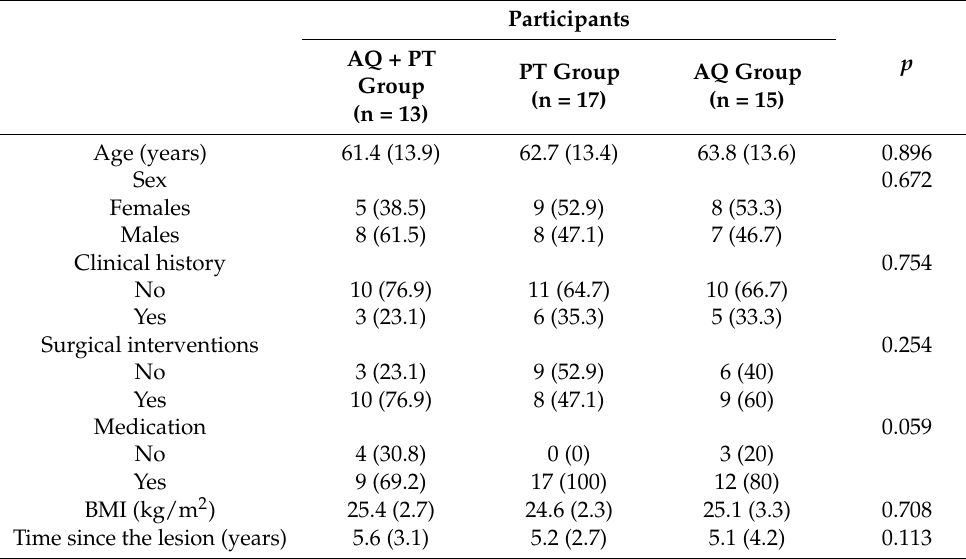
Table 1. Demographic and clinical characteristics of the study participants.